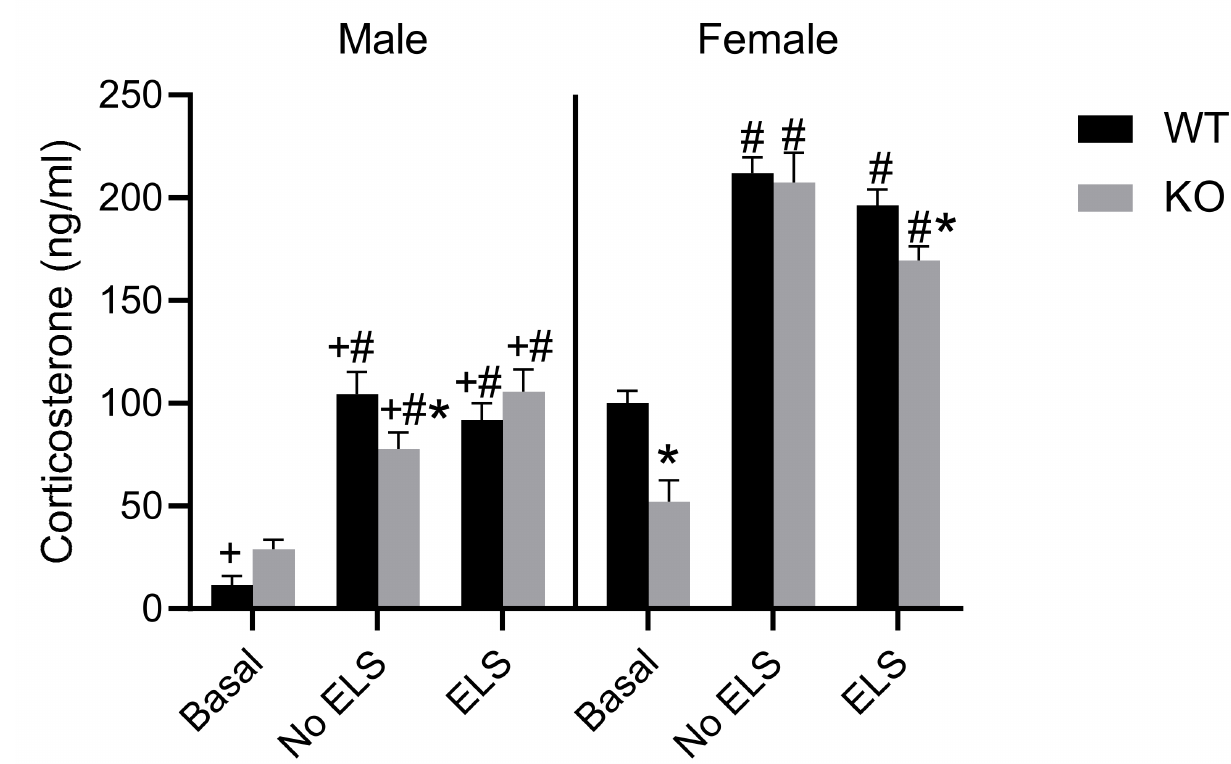
Figure 7. Effect of ELS in WT and GPR37KO mice on corticosterone levels in adulthood. N/group: WT no-ELS male = 5, WT ELS male = 6, KO no-ELS male = 7, KO ELS male = 5, WT no-ELS female = 5, WT ELS female = 7, KO no-ELS female = 7 and KO ELS female = 7. All data represent mean ± SEM. * p < 0.05 treatment difference within genotype; # p < 0.05 versus corresponding WT; + p < 0.05, with respect to sex; calculated by three-way ANOVA followed by multiple comparisons using two-stage linear step-up procedure of Benjamini, Krieger and Yekutieli. WT = Wild Type, KO = Knockout, ELS = Early Life